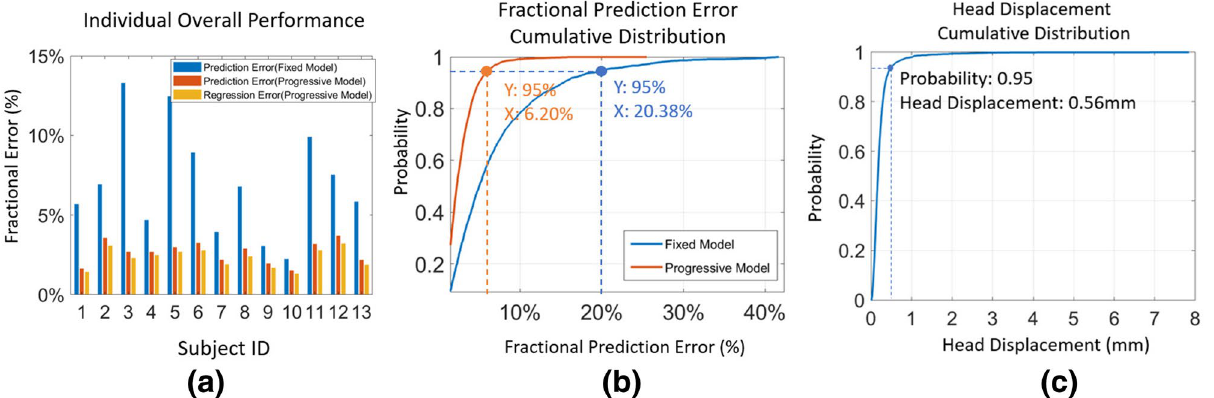
Figure 9. Gaze system performance: ( a ) the individual performance graph showing the mean absolute error (MAE) of prediction and regression of all targets for each subject. ( b ) The cumulative distribution for prediction errors for all targets for all subjects (progressive calibration in orange, fixed model in blue). ( c ) Cumulative distribution of the head displacement since previous fixation for all